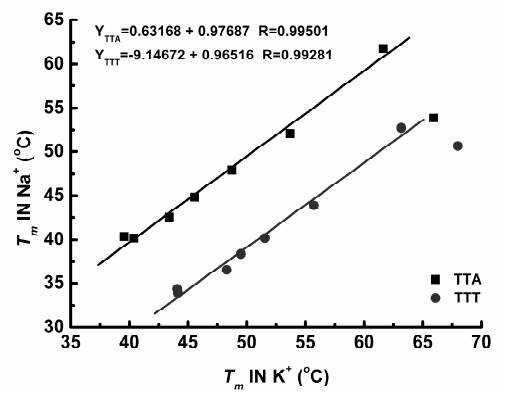
Figure 8. Correlation between melting temperatures of TTA and TTT sequences in 100 mM Na + and in 100 mM K + solutions, respectively.